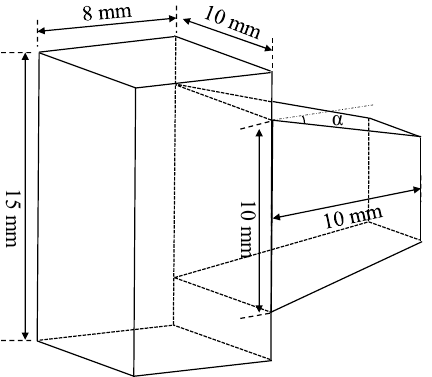
Figure 1. Schematic of the Quadrangular Frustum Pyramid Prism structure.